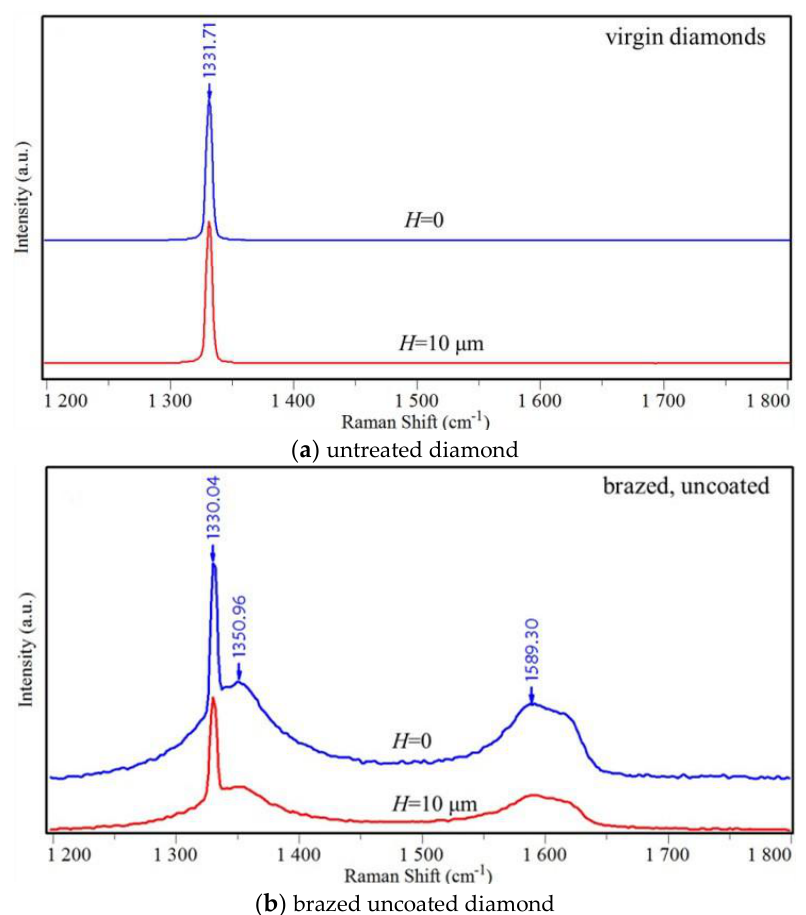
Figure 8. Representative Raman spectra of diamonds tested at two depths (H = 0 μm and H = 10 μm) [35], Taylor & Francis, 2018.